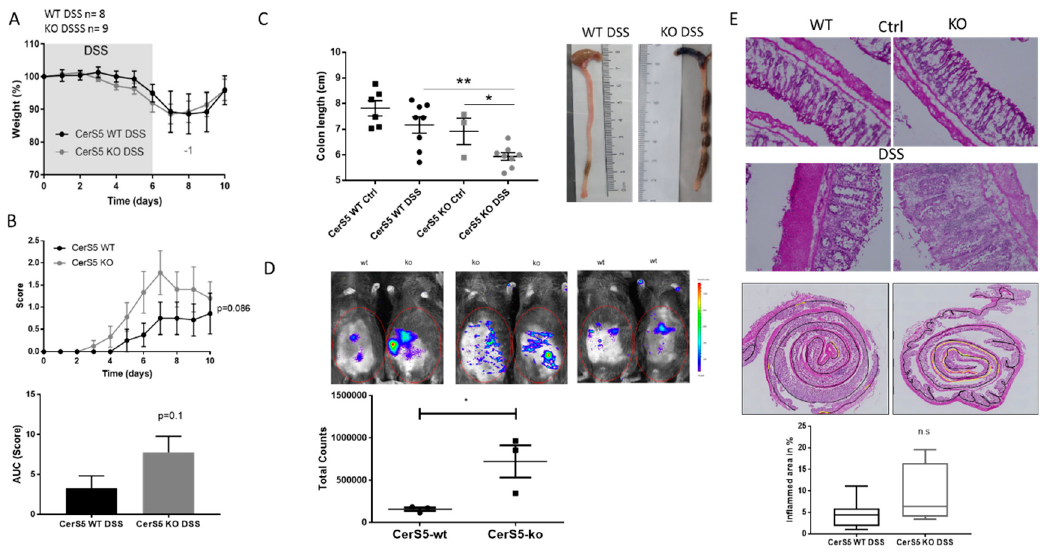
Figure 1. Clinical course and pathology of dextran sulfate sodium (DSS)-induced acute colitis in ceramide synthase 5 (CerS5)-wt and CerS5-knockout (ko) mice. Application of 2% DSS in the drinking water for 6 days reduced body weight ( A ) and increased disease score ( B ) of wt and CerS5-ko mice over time. Area under the curve (AUC) was calculated with the trapezoidal rule. ( C ) Colon length was significantly reduced in CerS5-wt and CerS5-ko mice after DSS treatment in comparison to control (Ctrl) mice. ( D ) Bioluminescence imaging of inflammation with an IVIS Lumina Spectrum. At day 10 of DSS treatment, colitis was detected in living animals by intraperitoneal (i.p.) injection of 200 mg / kg inflammation probe and subsequent detection of bioluminescence in the abdomen of CerS5-wt and CerS5-ko mice. The total luminescent counts in the abdominal regions of interest were quantified. ( E ) Sections of colon rolls, 10 µ m in size, were stained with hematoxylin / eosin, and images were taken with a Keyence BZ-9000 microscope. Inflamed colon areas (yellow marked area in the colon rolls) were sized and related to the whole colon length (black marked area) (wt DSS group n = 9; ko DSS group n = 4). Data are mean ± standard error of the mean (SEM) of n = 8 / 9 animals, for bioluminescence imaging n = 3 animals in each group. Statistical analysis was performed by unpaired t -test ( B – E ) or one-way ANOVA ( C ); p * < 0.05, p ** <